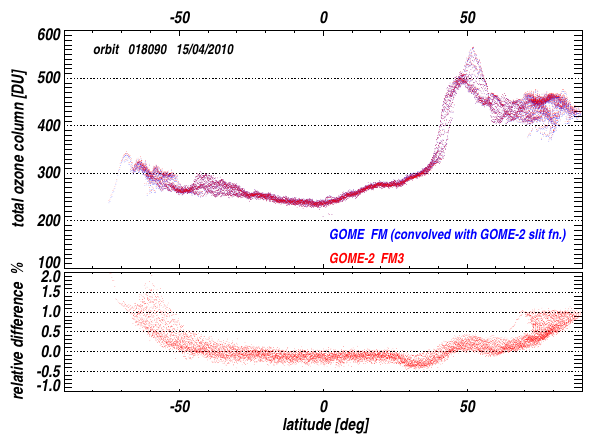
Fig. 7. GOME-2 total ozone column retrievals with different cross section data as indicated for orbit 018090 (top panel) and differ- ences between them in percent (bottom panel).